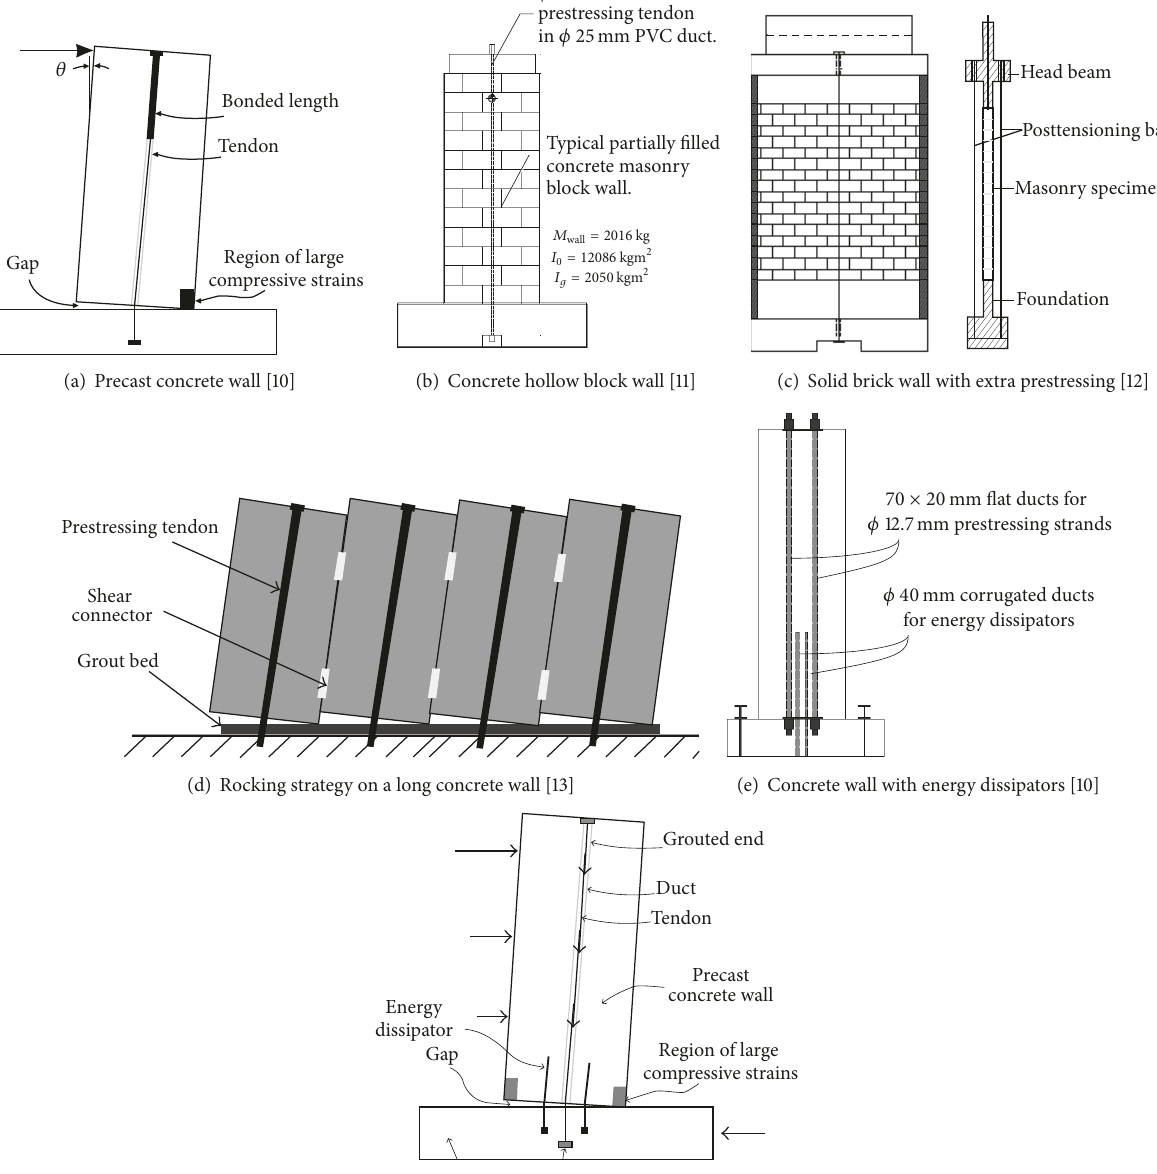
Figure 2: Existing tests and strategy of rocking walls with prestressed